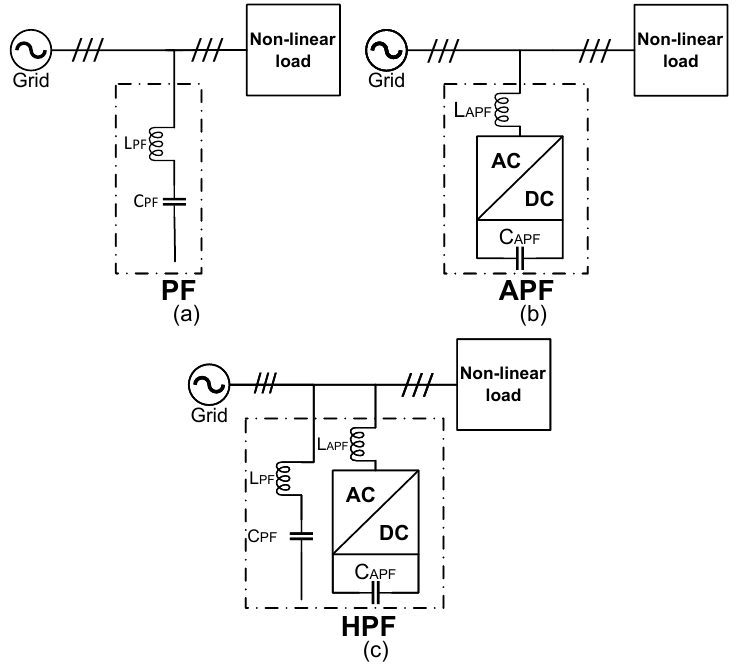
Figure 5. Filter topologies: ( a ) passive filter (PF); ( b ) active power filter (APF); ( c ) hybrid power filter